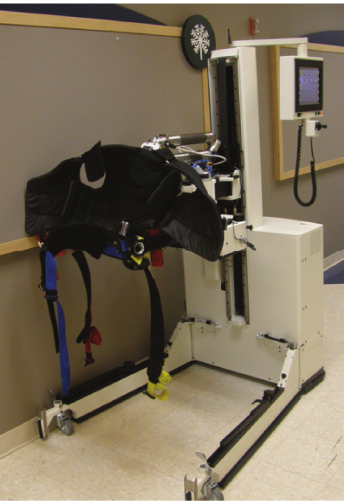
Figure 8: ReWalk wearable system (picture courtesy of ARGO Medical Technologies Ltd.).